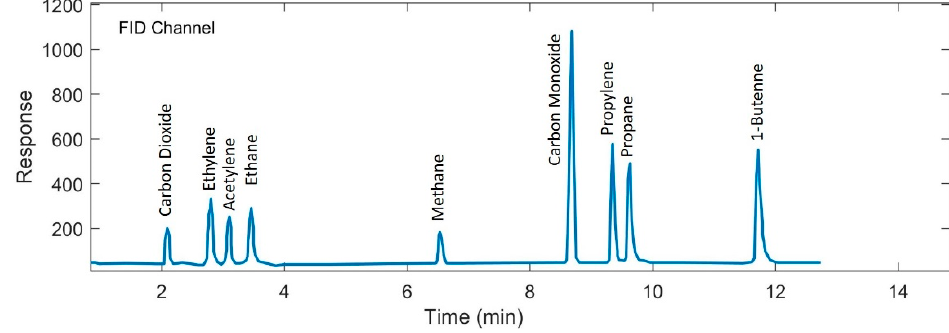
Table 3. Diagnosis results of some cases.